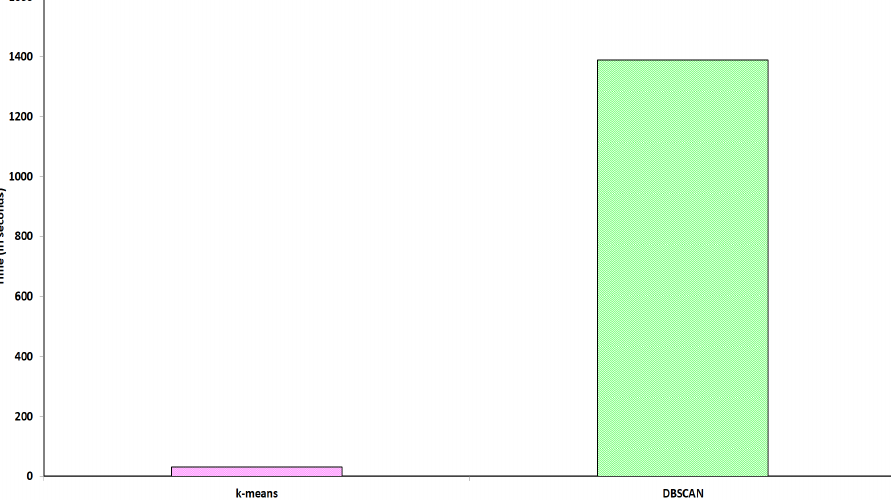
Figure 22. Execution time for K-means clustering and DBSCAN